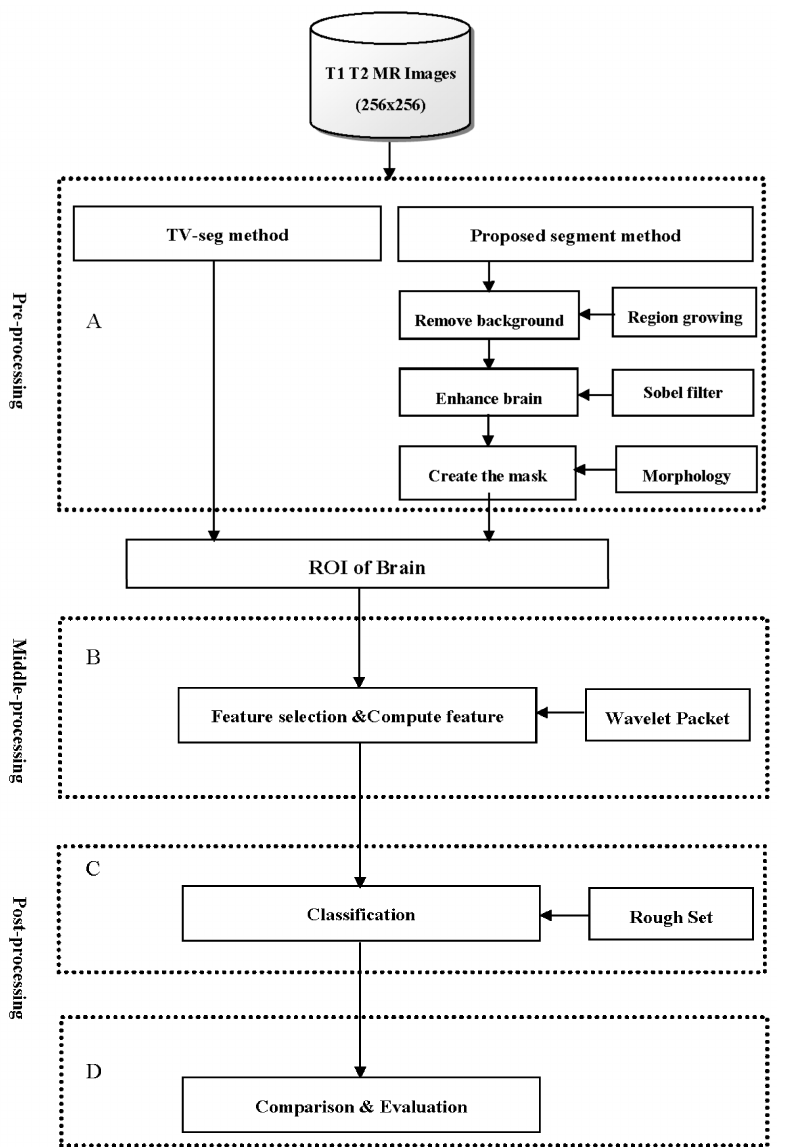
Figure 1. The procedure of proposed method. ( A ) a segmentation block, ( B ) an image transformation block, ( C ) a classification block, and ( D ) a comparison